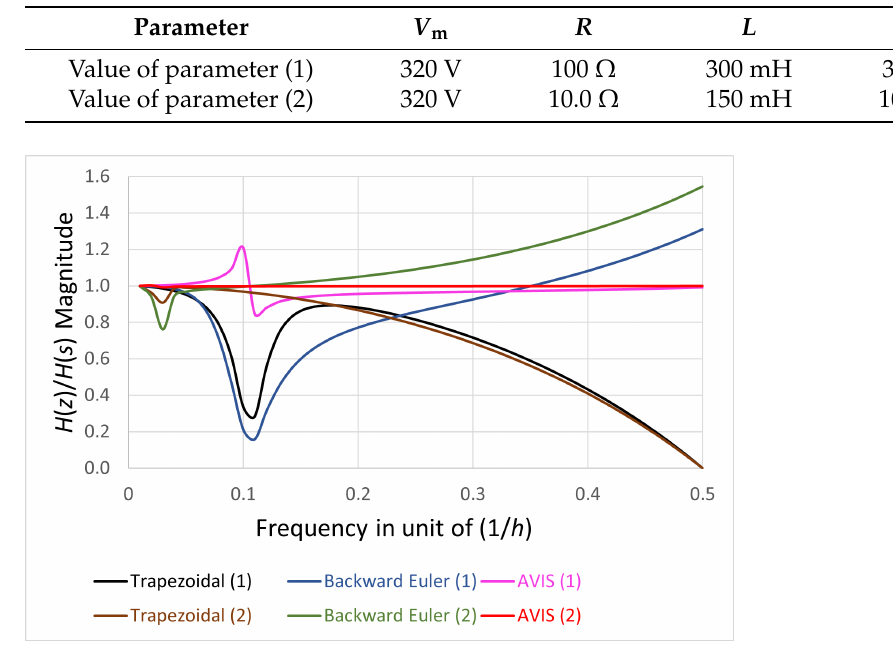
Table 2. Parameters of the considered branch of the electrical circuit.